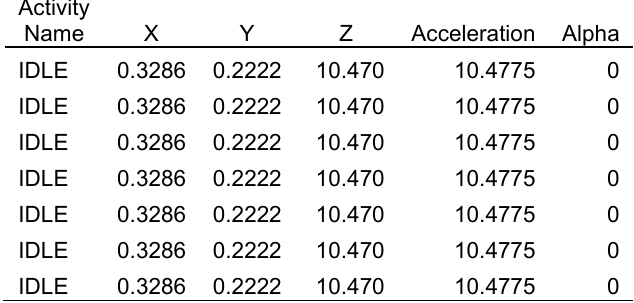
Table 2. Overall Acceleration in Idle Case without